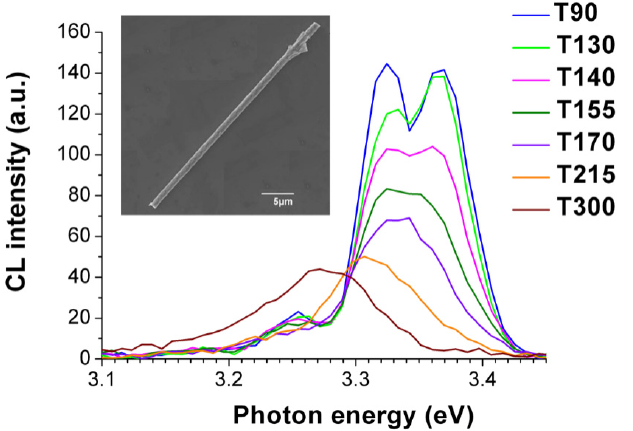
Figure 5. CL spectra measured on an individual NR in the temperature range from 90 to 300 K. In the inset, the SEM image of NR studied is shown.